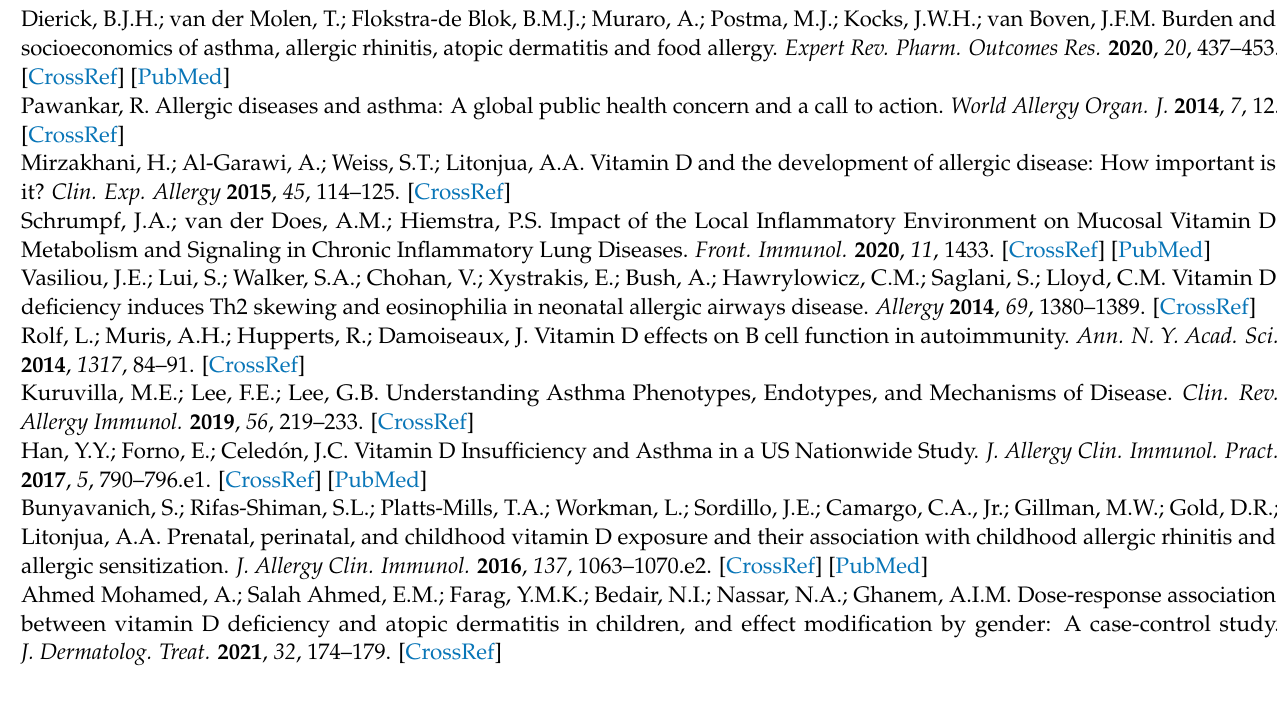
outcomes among children with asthma, Figure S3: Sensitivity analyses of number of children with one or more asthma exacerbations, Figure S4: Publication bias of number of children with one or more asthma exacerbations, Figure S5: Sensitivity analyses of atopic dermatitis severity, Figure S6: Meta analyses of change in serum 25(OH)D concentration before and after intervention, Figure